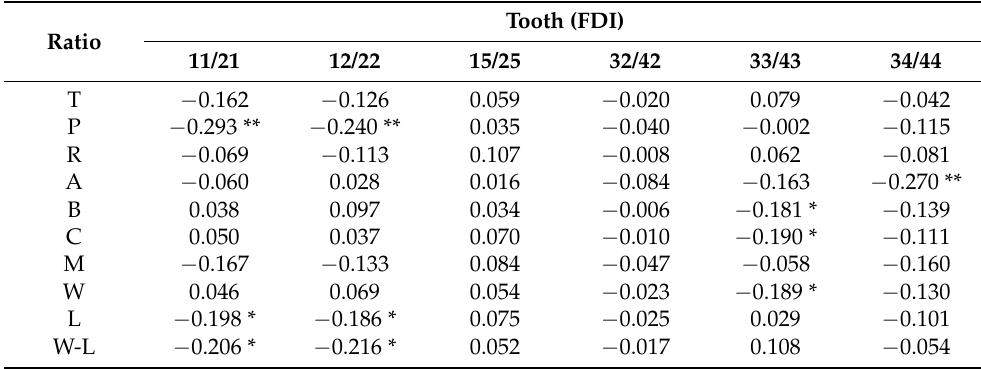
Table 2. Correlation coefficients between chronological age and the Kvaal dental ratios a .